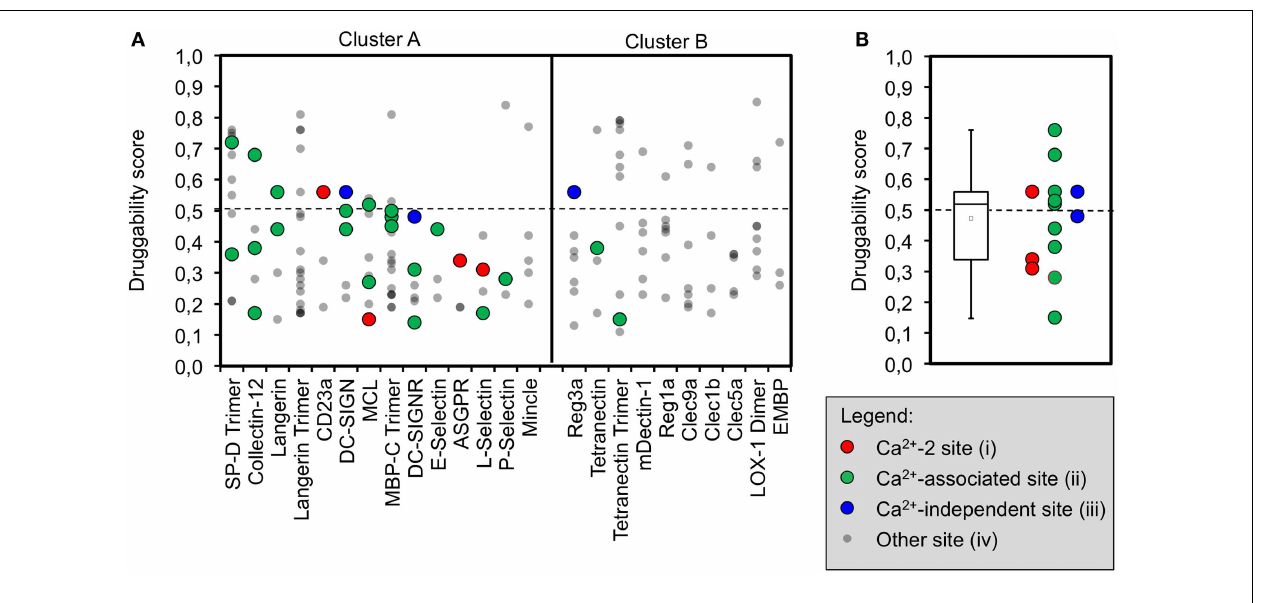
the corresponding category (red: Ca 2 + -2-binding sites (i), green: Ca 2 + -associated binding sites in long loop region (ii), blue: previously reported Ca 2 + -independent carbohydrate-binding sites (iii), gray: other binding sites). (B) A boxplot of the highest druggability scores of categories (i) to (iii) of each CTLR is shown.Tukey-style representation was